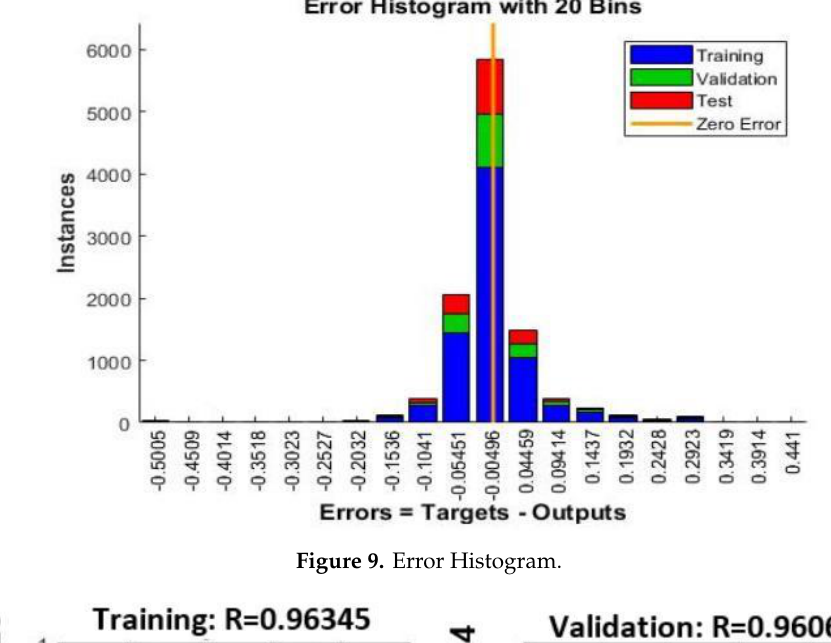
Figure 9. Error Histogram.